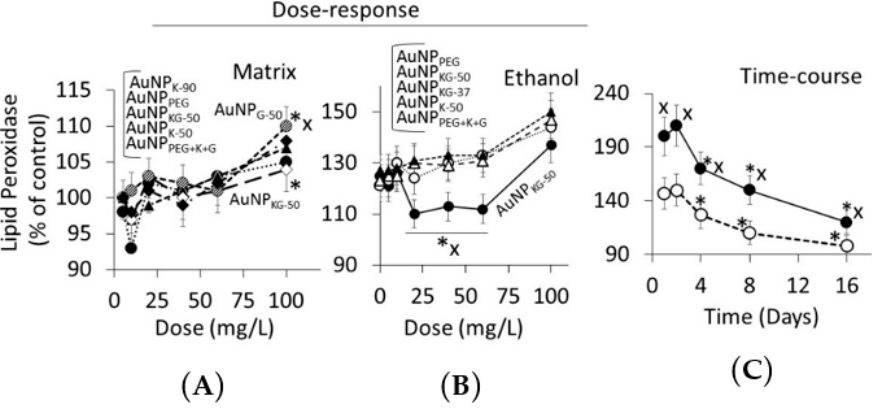
Figure 10. ( A ) Plots of dose (AuNP mg/L) versus intracellular lipid peroxidase activity in Ap/En cells (% of control) at day 16. A 5 to 60 mg/L dose of all AuNPs exhibited comparable response. Only 100 mg/L dose caused significant but variable increase in enzyme activity (AuNP KG-50 exhibited lowest, while AuNP G-50 exhibited highest activity in response to 100 mg/L dose). Values are mean ± SD; ( B ) Plots of dose (AuNP mg/L) versus intracellular lipid peroxidase activity in Ap/Ep cells (% of control) at day 16. Different AuNPs yielded variable response, but maximum protection was provided by AuNP KG-50 at 20 to 60 mg/L dose. Values are mean ± SD. *: p < 0.05 when Ap/En or Ap/Ep values were compared with An/En values. X, # or @: p < 0.05, when enzyme activity of Ap/Ep cells exposed to a given dose of and AuNP compared with enzyme activity of Ap/Ep cells exposed to the same dose of other AuNPs; ( C ) The time course of change in enzyme activity of Ap/En (broken line) and Ap/Ep (solid line) cell pre-exposed to a 20 mg/L dose of AuNP KG-50 . *: p < 0.05 when exposed to day 0 values, and x: p < 0.05 when Ap/En and Ap/Ep values were compared at each time interval.